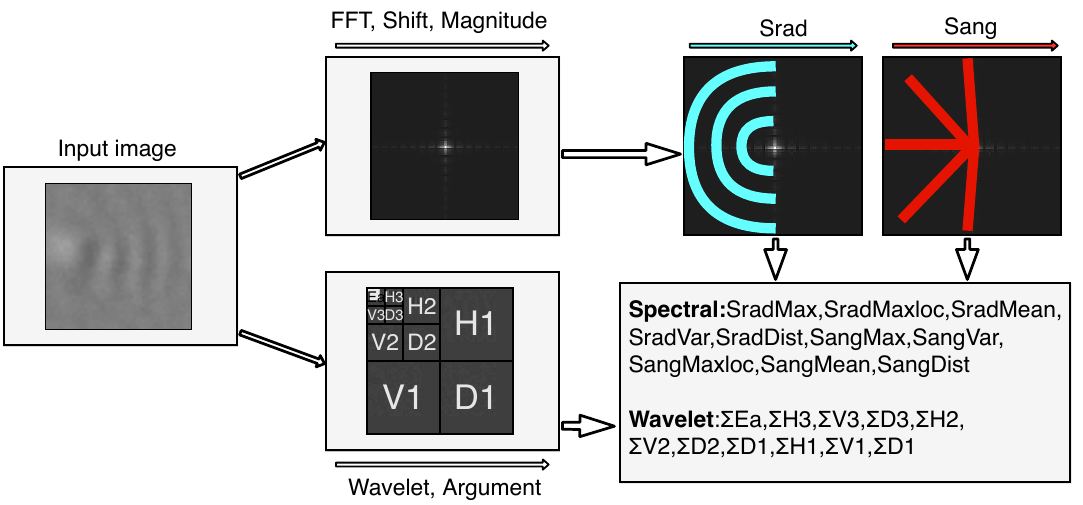
Figure 4. The main steps of feature extraction process. In the top branch, the extraction of Fourier features is illustrated. In the bottom branch, the extraction of Haar wavelet features is